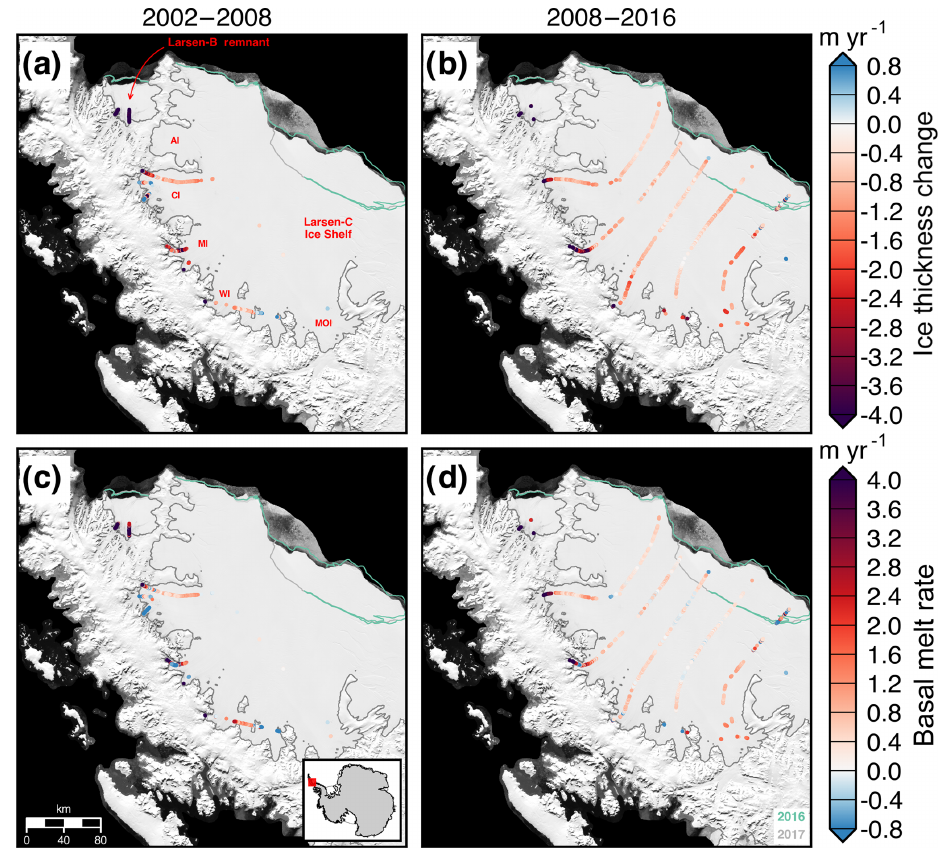
Figure 6. Ice thickness change (a–b) and estimated basal melt rates (c–d) of the Larsen-B remnant and Larsen-C Ice Shelf for two periods, 2002–2008 and 2008–2016. AI, CI, MI, WI, and MOI denote the Adie, Cabinet, Mill, Whirlwind, and Mobiloil inlets, respectively. MEa- SUREs InSAR-derived Antarctic grounded ice boundaries are denoted in gray (Mouginot et al., 2017b). The 2016 and 2017 ice shelf extents delineated from MODIS imagery are denoted in green and light gray, respectively (Scambos et al., 2001). Plots are overlaid on a 2008–2009 MODIS mosaic of Antarctica (Haran et al., 2014). The inset map denotes the location of the